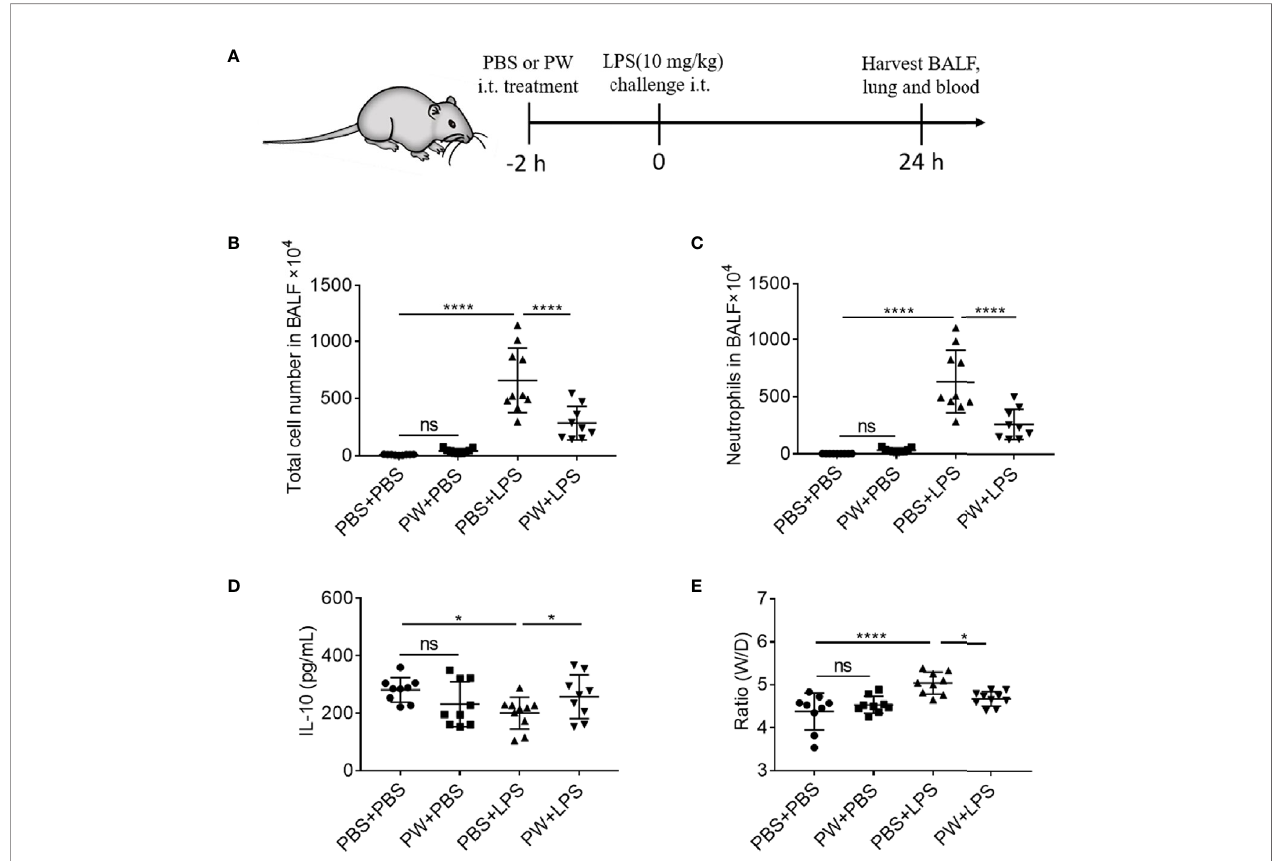
FIGURE 7 | The inhibitory effect of PW on the lung in fl ammation in LPS-induced ALI mice. (A) The scheme of the LPS-induced ALI mouse model; PW (1.25 nmol/ kg) was intratracheally administered 2 h before the LPS (10 mg/kg) challenge through the same route for 24 h; the BALF was collected for the analysis of the total number of cells (B) and the neutrophils (C) in fi ltrated in the lung. (D) The level of the anti-in fl ammatory cytokine IL-10 in the BALF. (E) The pulmonary edema assessed by the lung W/D ratio. N ≥ 9 per group; ns, not signi fi cant, *p < 0.05, ****p <